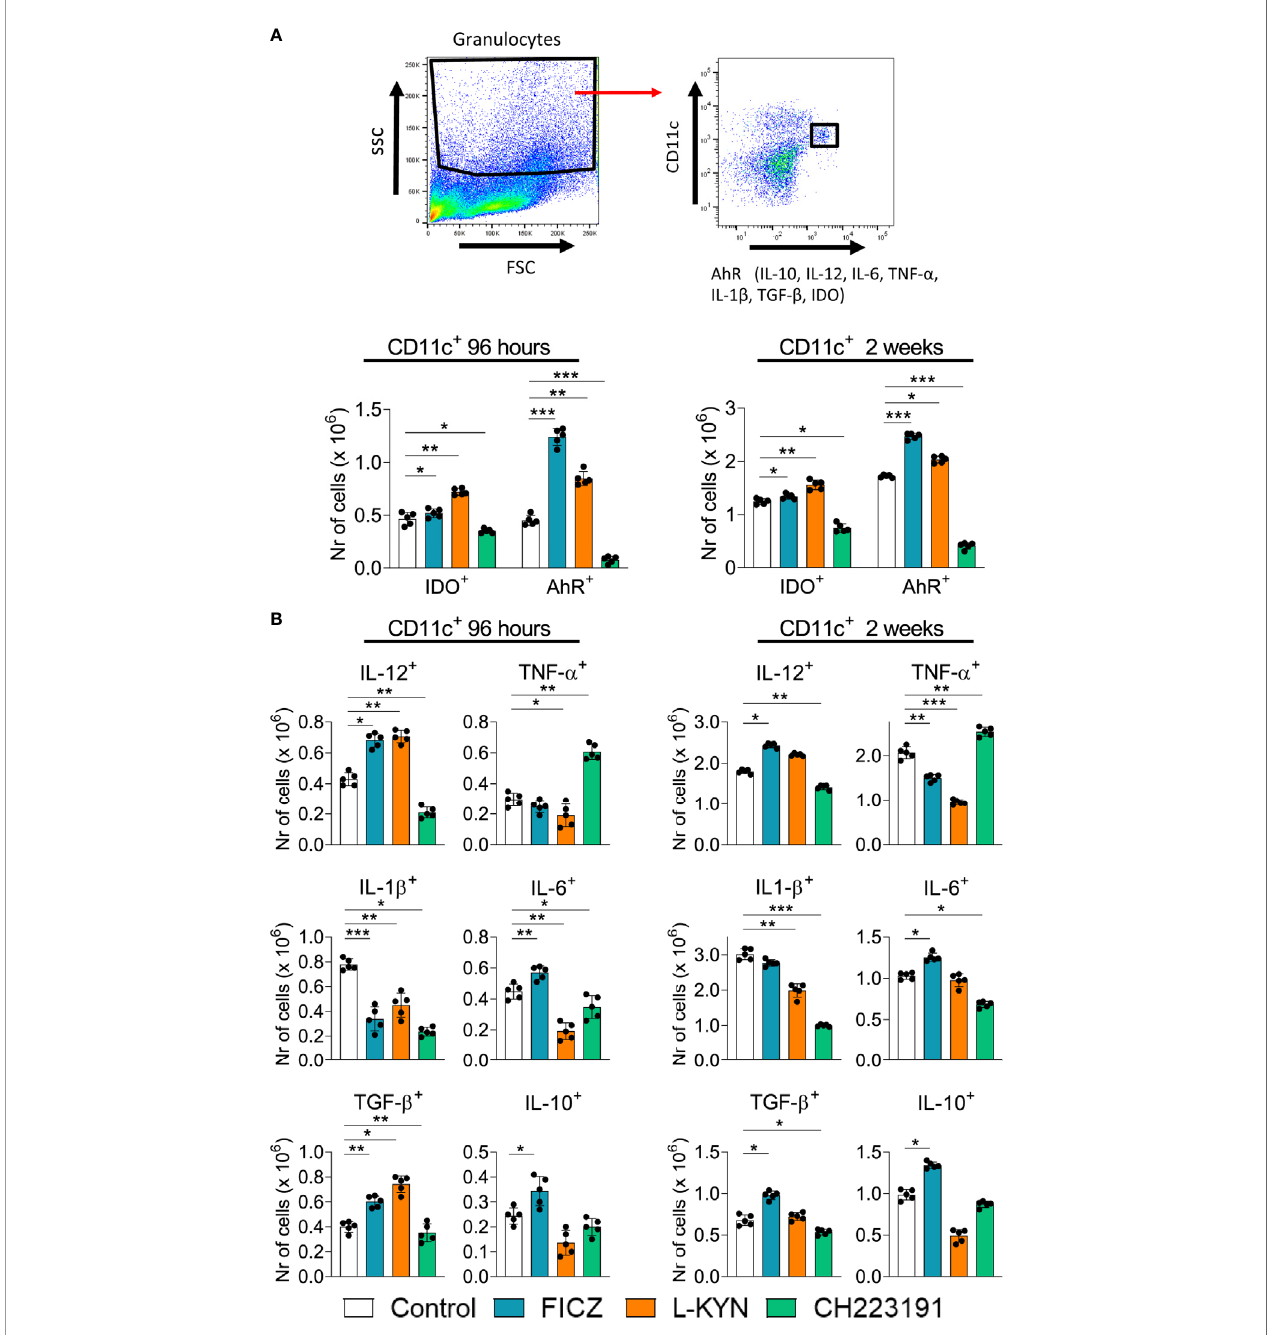
FIGURE 3 | Treatment with AhR ligands (FICZ, L-Kyn, and CH2231991) alters the intracellular expression of IDO, AhR, and cytokines by pulmonary myeloid CD11c+ cells from P. brasiliensis infected mice. C57BL/6 mice (n = 5) were infected with 1 x 10 6 P. brasiliensis yeasts and treated by route i,p. on alternate days with FICZ, L-Kyn, or CH223191 at doses of 200, 800, or 400 m g/animal, respectively. Control mice were treated with PBS. The animals were sacri fi ced 96 hours and 2 weeks after infection, their lungs removed, macerated and CD11c+ leukocytes analyzed by fl ow cytometry for the intracellular expression of the enzyme IDO, the AhR transcription factor, and cytokines (IL-12, TNF- a , IL -1 b , IL-6, TGB- b and IL-10). (A) Gate strategy to de fi ne CD11c+ expressing IDO, AhR, and cytokines. (B) Number of pulmonary CD11c+ cells expressing AhR, IDO and cytokines detected at 96 hours and 2 weeks after infection. The experiment was repeated twice, and data are expressed as M ± SD. P values < 0.05 were considered signi fi cant (* p < 0.05; ** p < 0.005 and *** p <